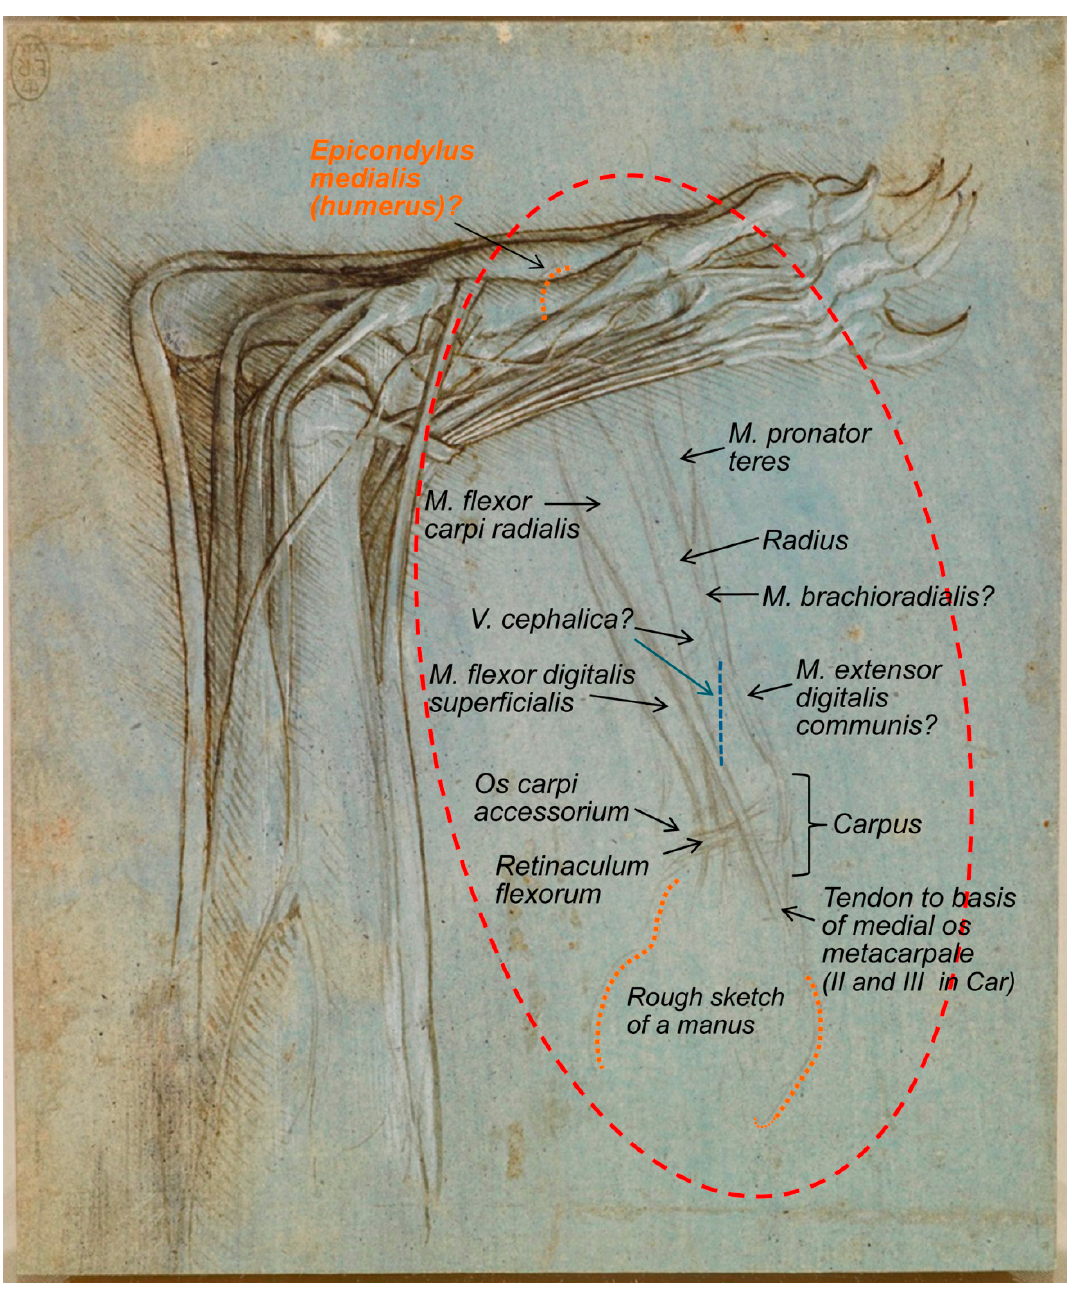
Figure 2. An antebrachium of a dog/wolf. Dog/wolf antebrachium and manus ,